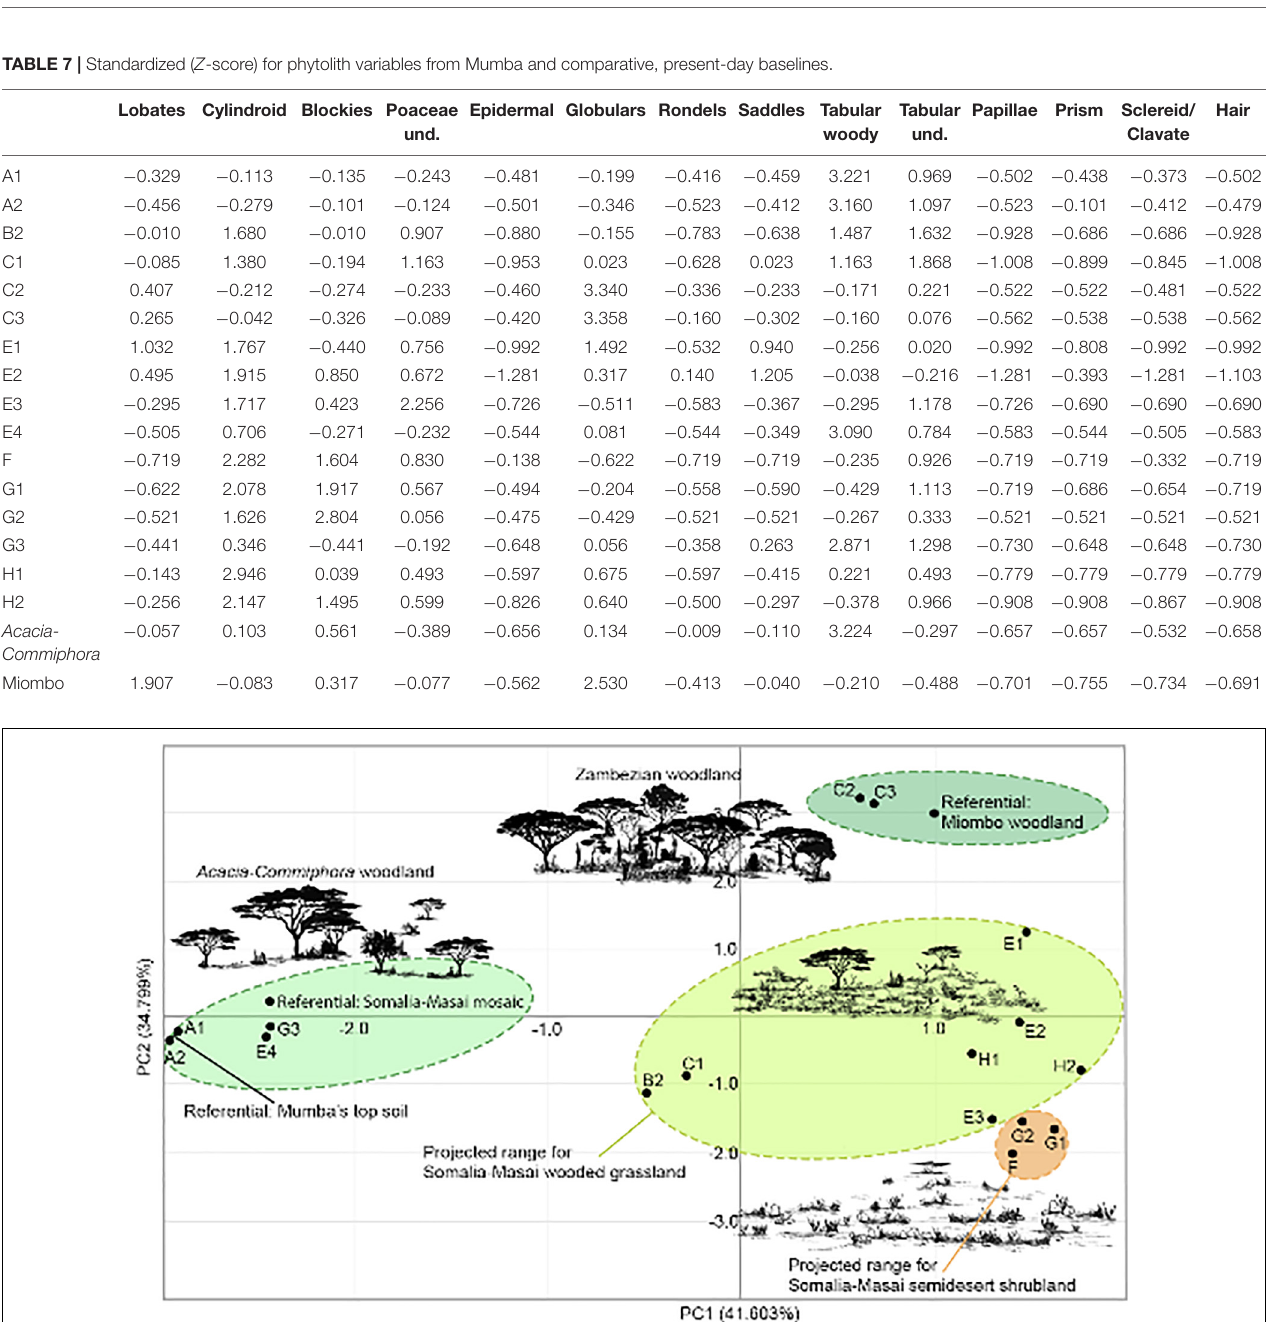
FIGURE 8 | Principal component analysis of Mumba phytoliths.